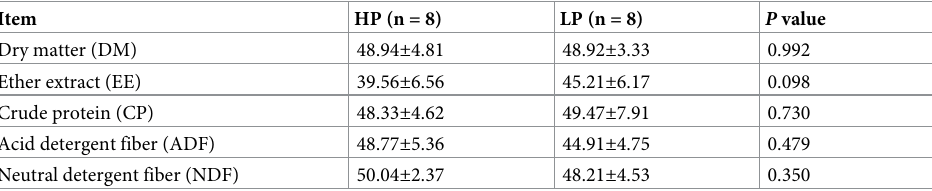
Table 4. Comparison of apparent digestibility of nutrients between the HP and LP groups